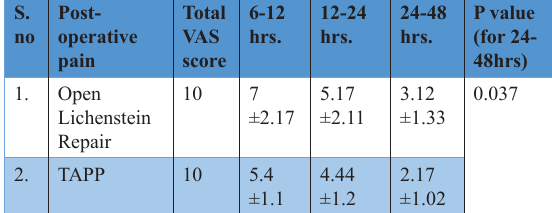
Table 4. Post- operative complications during hernia repair Complications Total Open S. no